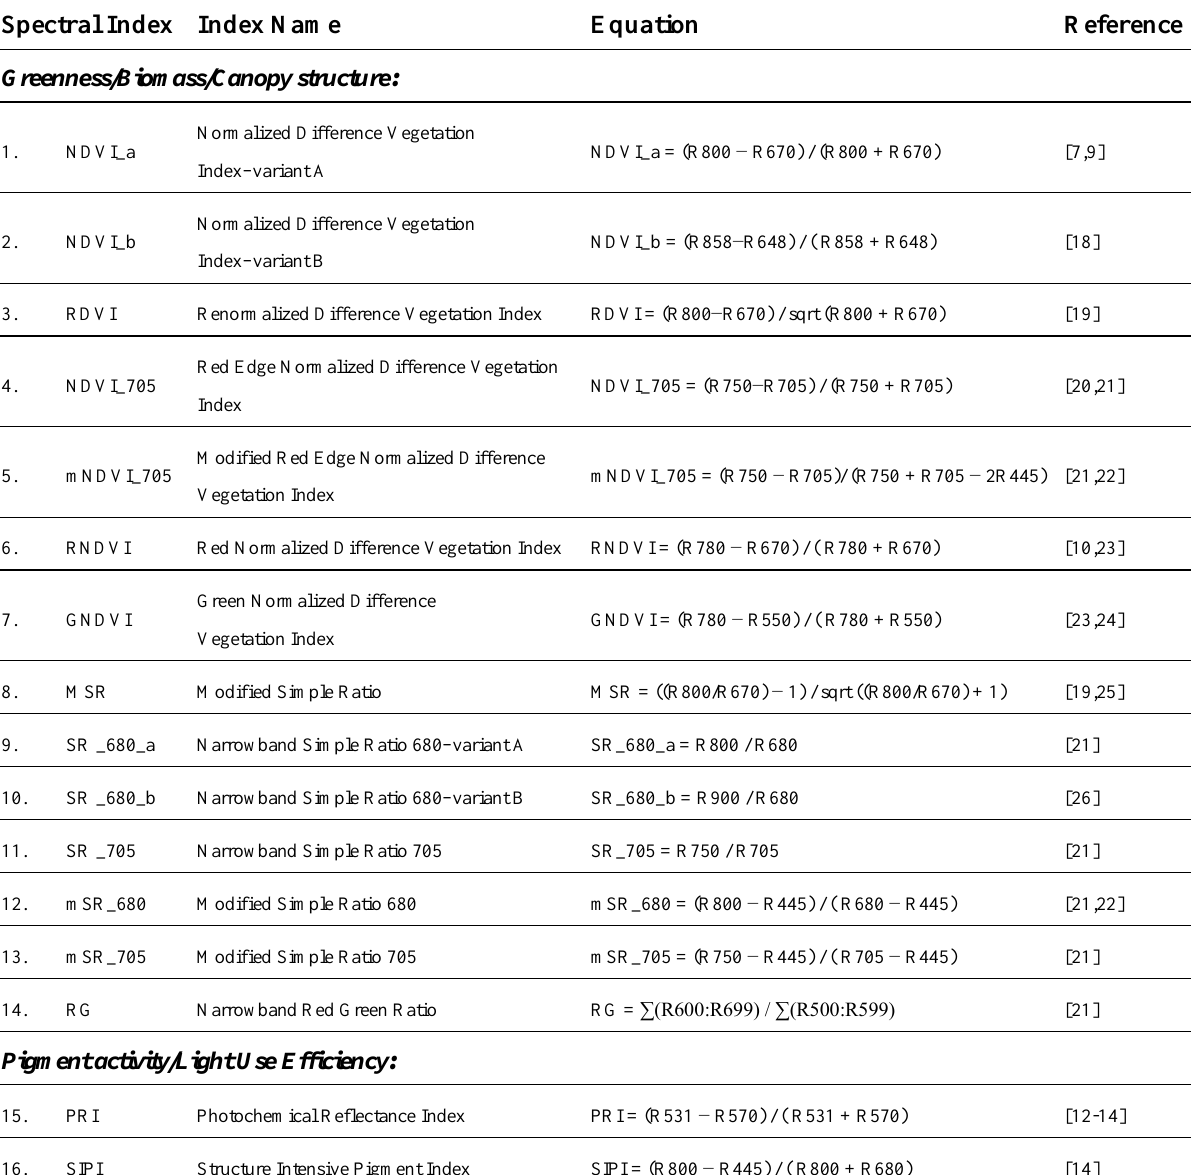
Table 1. List of SI’s to describe plant ecophysiological parameters reviewed from the literature and used throughout this paper. SI’s are grouped into three general classes showing response to (a) greenness, biomass and structure of the vegetation, (b) light use efficiency, and (c) vegetation and leaf water content. R specific wavelength